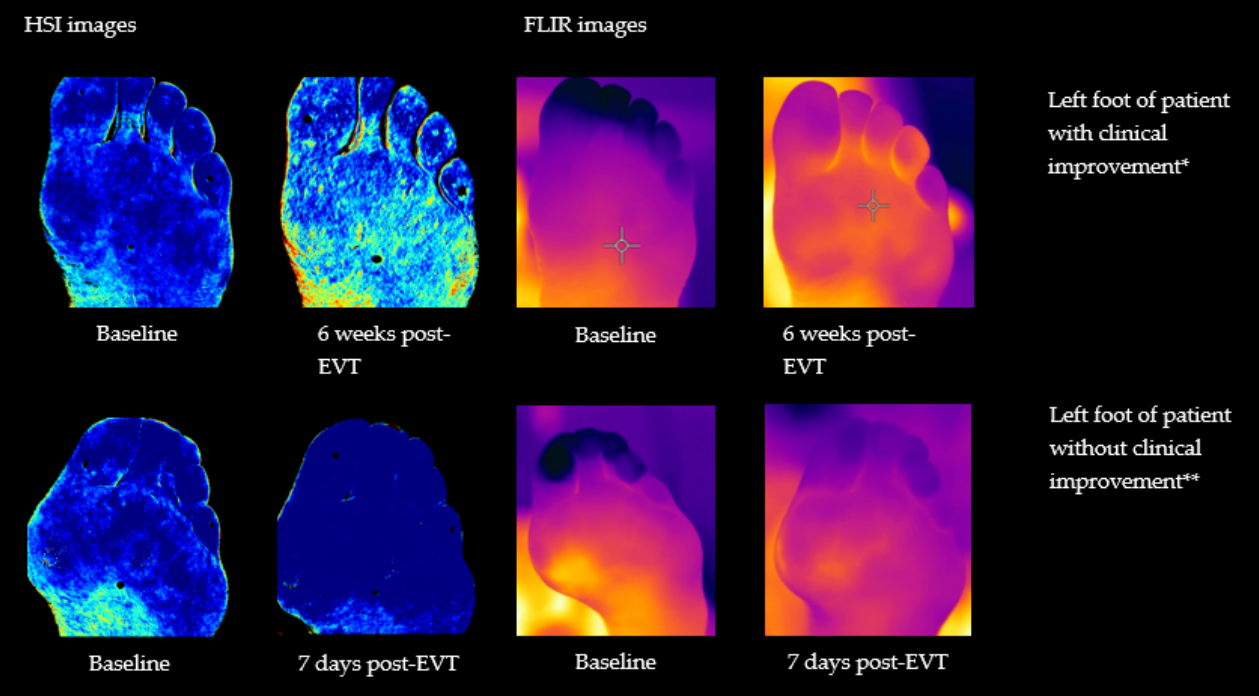
Figure 3. Hyperspectral (HS) images of the deoxyhemoglobin concentration with the HyperView system and FLIR (thermal) images of the plantar side of the left foot of a patient with clinical improvement * at baseline and 6 weeks post-EVT and without clinical improvement ** at baseline and 7 days post-EVT. A darker blue color in the hyperspectral images means a higher deoxyhemoglobin value. A darker purple color means a lower temperature value and more yellow color means a higher temperature value for the thermal images. * Patient does not smoke and has a Rutherford class four. ** Patient was a former smoker with Rutherford class three.